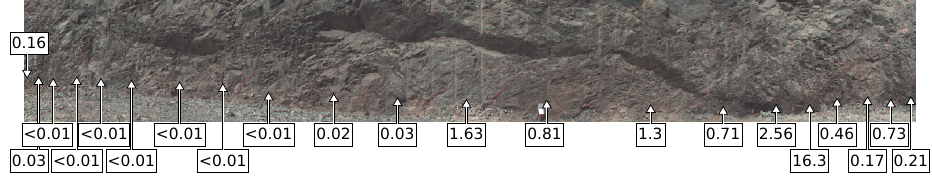
Figure 3. False, three-colour image of the scanned site, with approximate sample locations and gold concentration (ppm) obtained from fire assay. Gold content data provided by AngloGoldAshanti. The red, green, and blue channels display the 1000nm, 550nm, and 464nm bands from the data cube, respectively. The 1000nm channel from the short-wavelength infrared (SWIR) camera was selected to create an image that fuses information from both